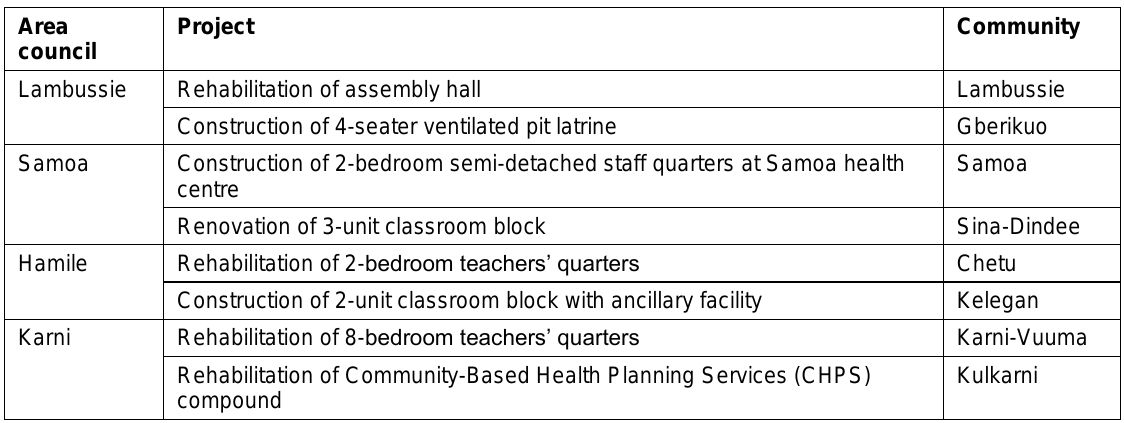
Table 1: Area councils, communities and projects